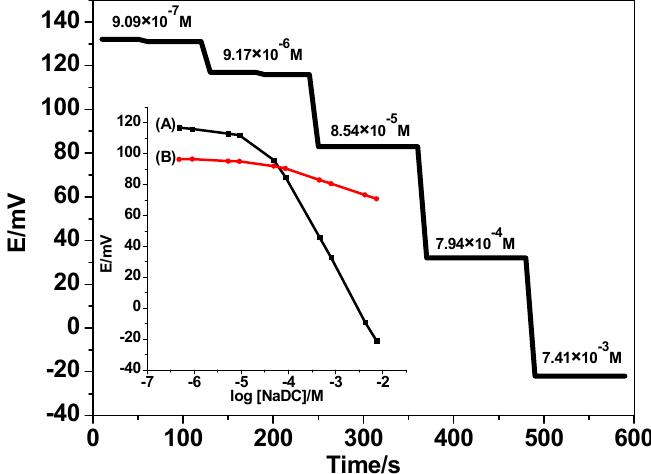
Figure 4. Potentiometric response curves obtained screen-printed ion-selective electrodes (ISEs) integrated with ( A ) MIP and ( B ) NIP.